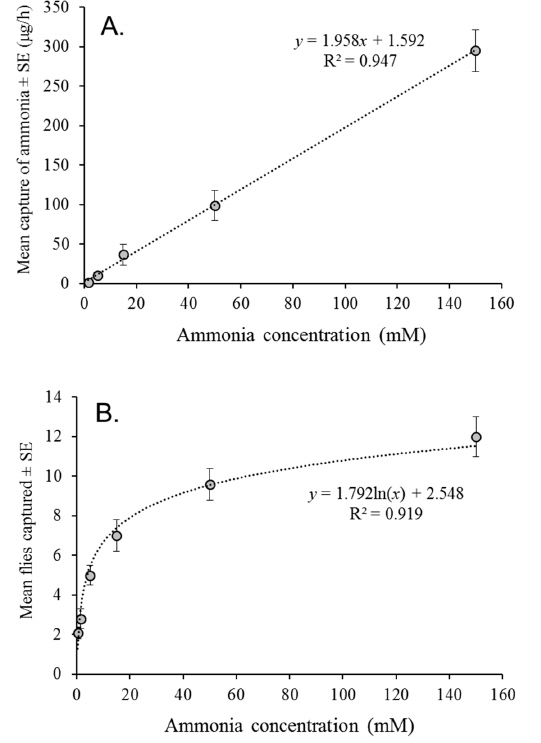
Figure 1. ( A ) Linear regression of ammonia concentration in solution and the quantity of gaseous ammonia released by traps over a one-hour period. ( B ) Logarithmic (ln) regression of mean numbers of flies caught in traps baited with different concentrations of ammonia